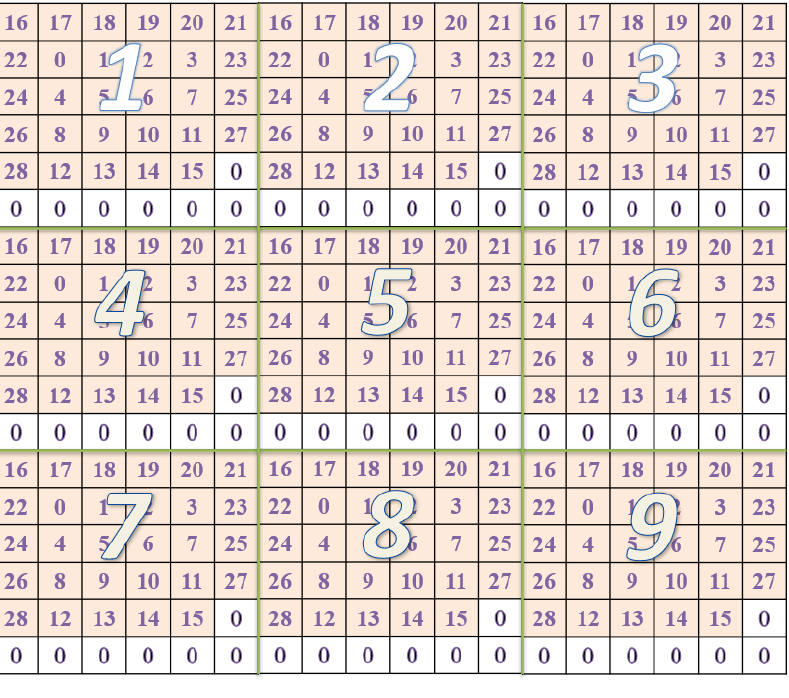
Figure 5. The data arrangement of 3 × 3 Mosaic pattern, with 29-bit ID.